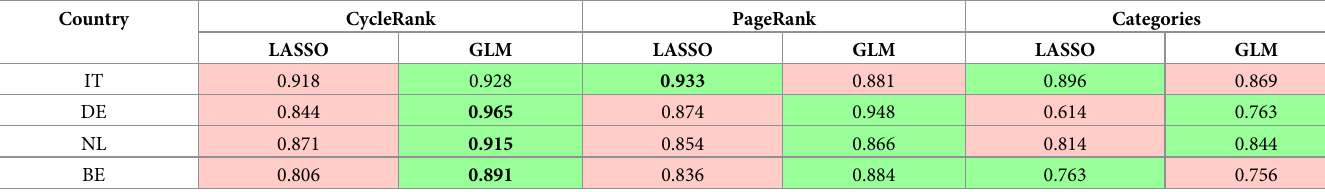
Table 5. R 2 comparison between LASSO and GLM best models. The bold values indicate the best results. The green colour indicates the best results by either using the GLM or the LASSO model, by keeping the country fixed (no colour means no changes). Country CycleRank PageRank IT DE NL